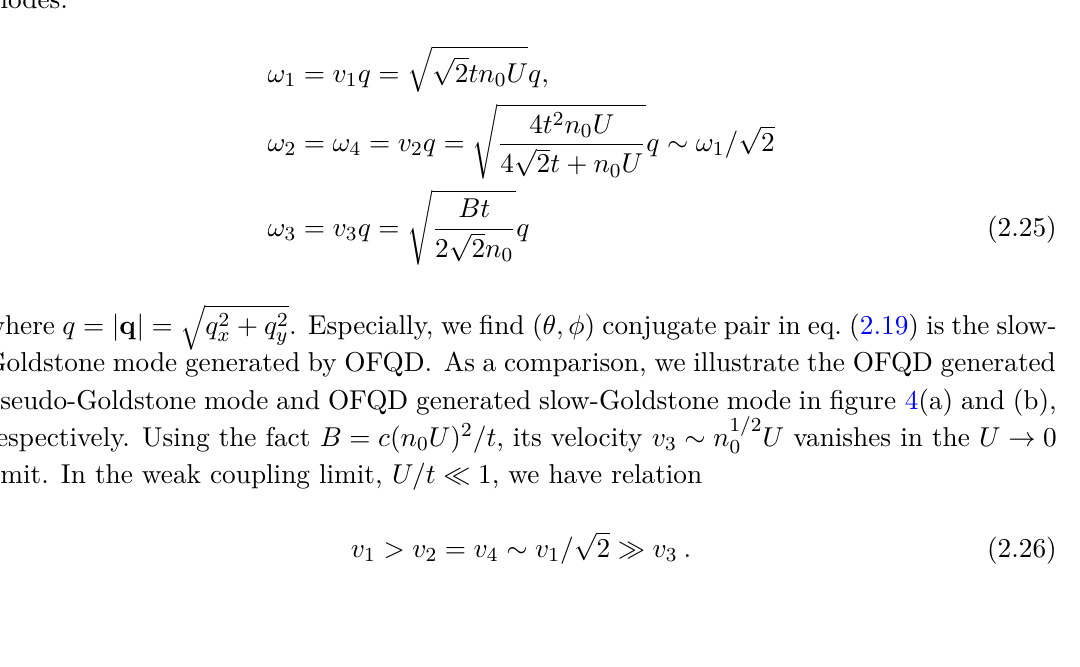
where the last term is the order-from-disorder generated potential. The Lagrangian